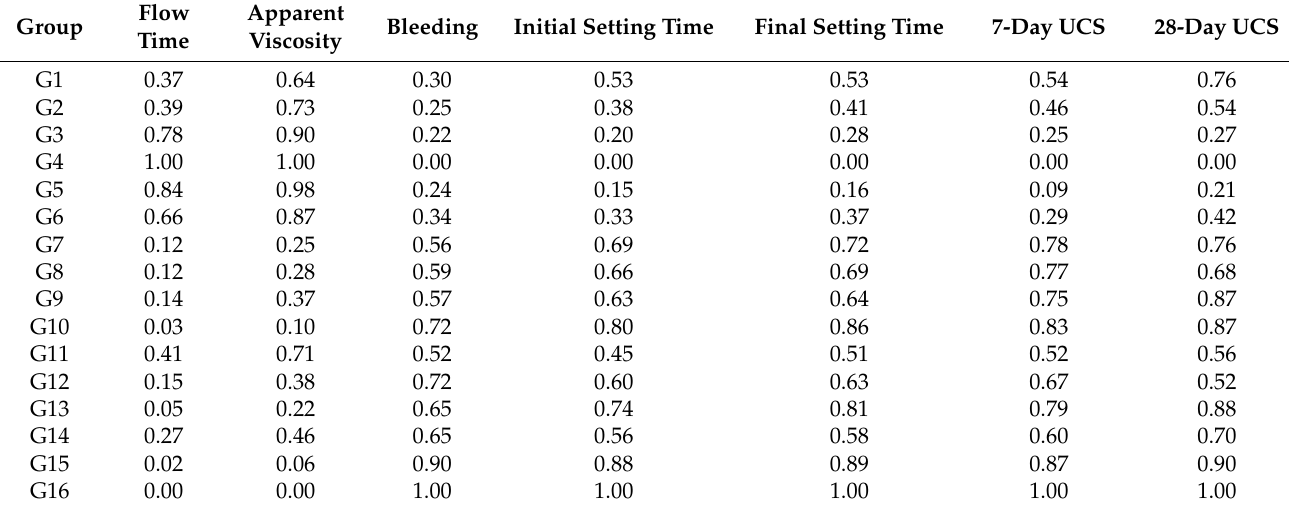
Table 9. Mass loss function values of different properties of the UC-based